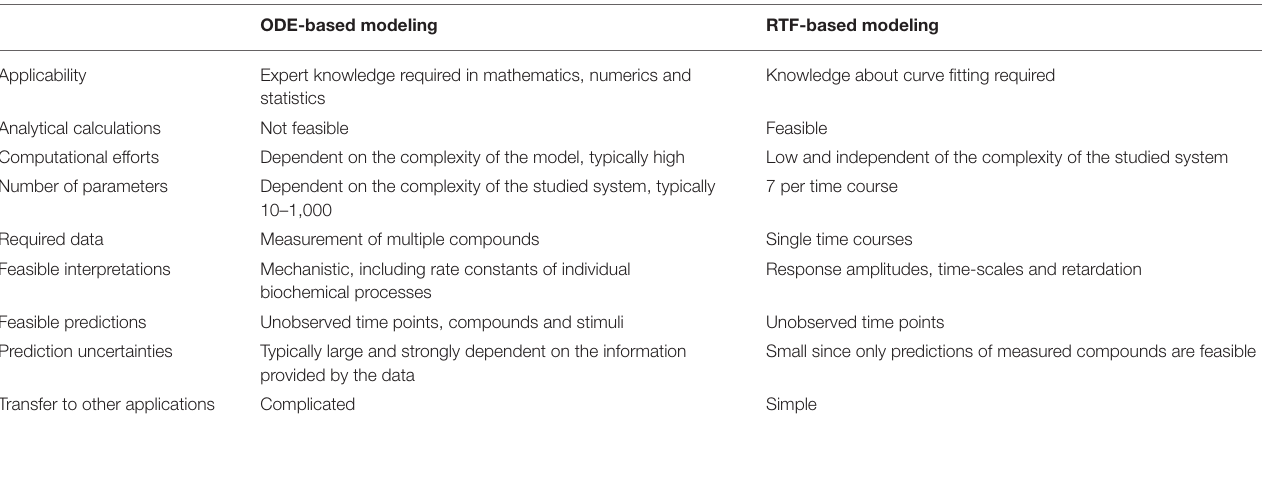
TABLE 2 | Comparison of major characteristics of RTF- and ODE-based